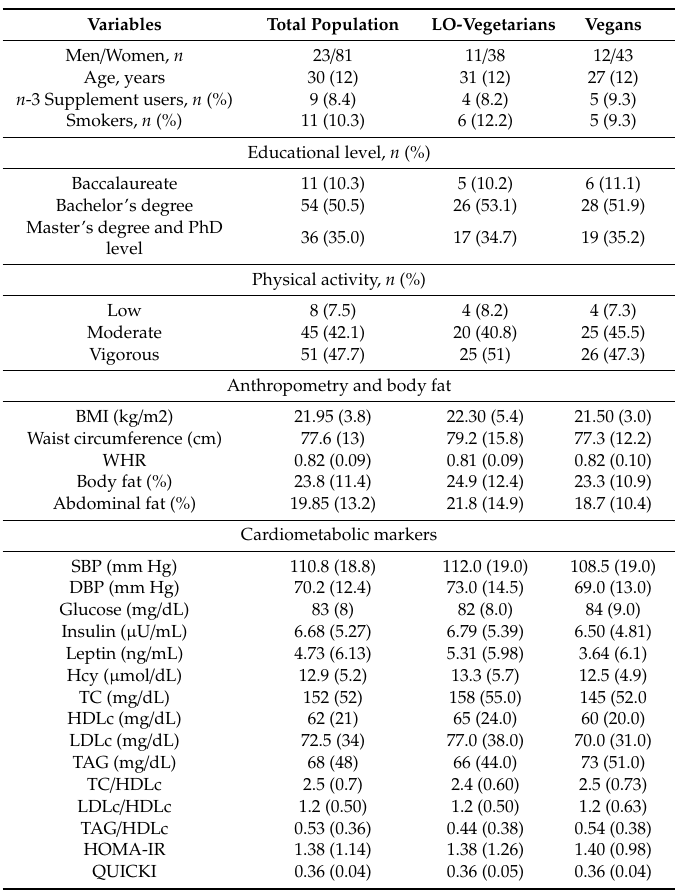
Table 1. Characteristics of the studied